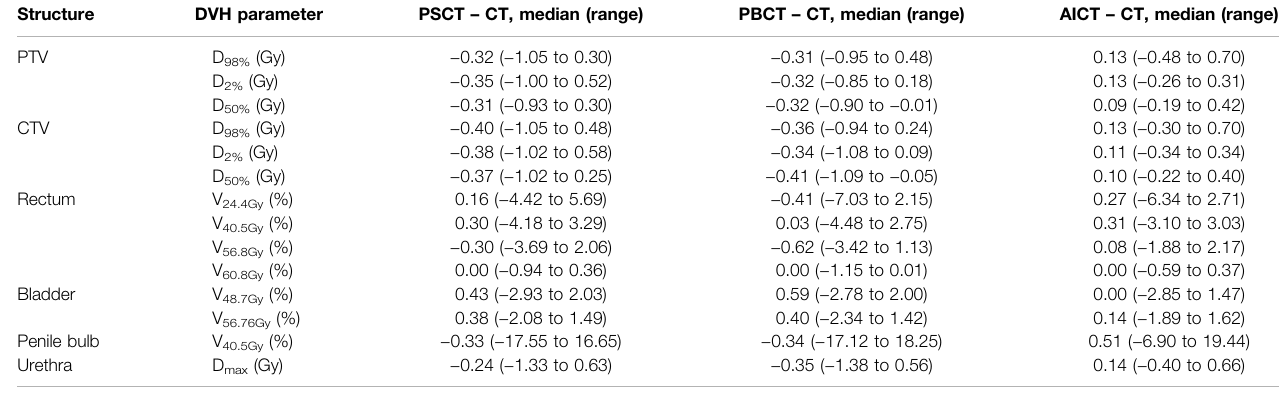
TABLE 4| Results onDVHparametersreportingthemedian(range)differenceforeachplanning approachtowardthegoldstandardCT-basedplanfortheconsideredDVH parameters based on the PRISM study. Structure